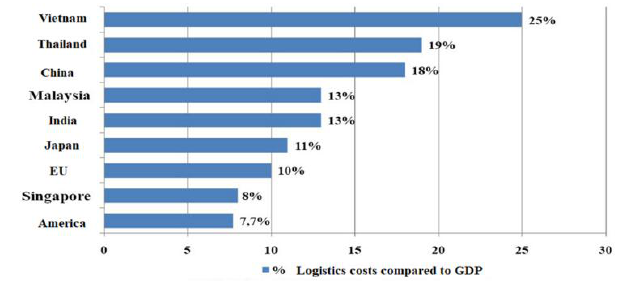
Figure 1: Logistics costs in regions and Vietnam [14]